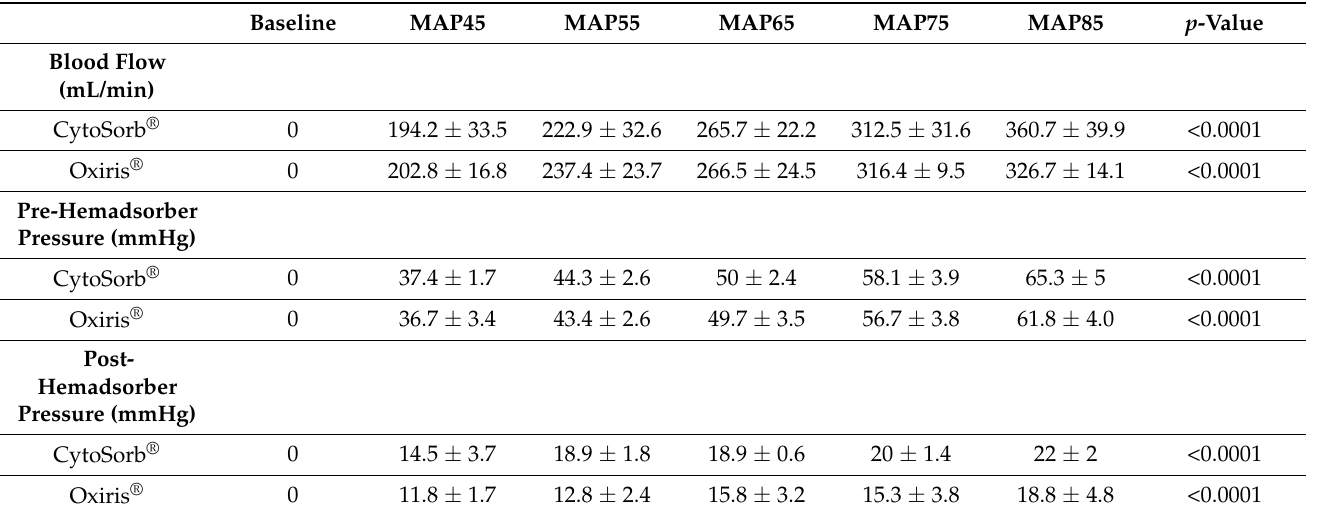
Table 2. Hemadsorber pressure and blood flow.